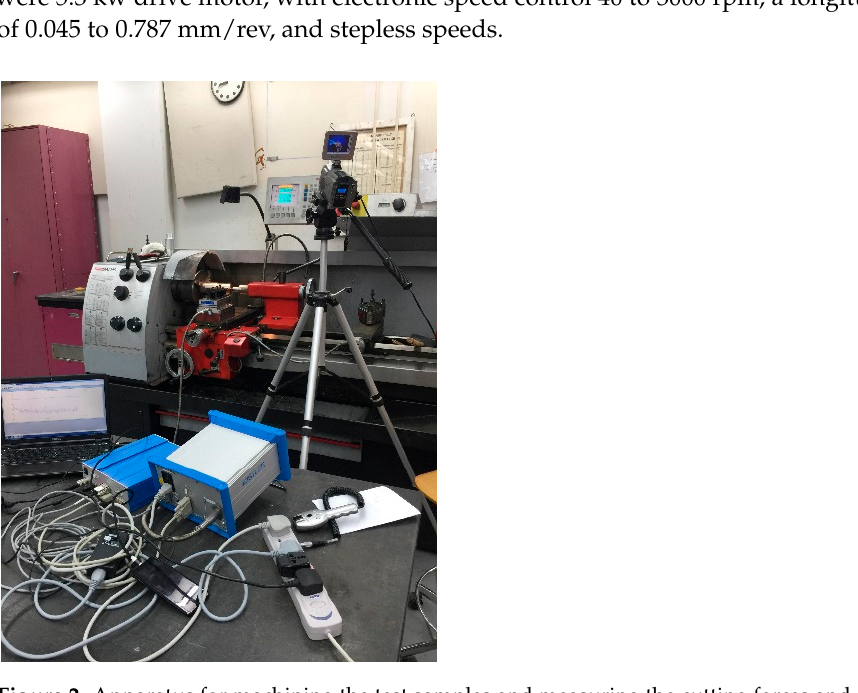
Figure 2. Apparatus for machining the test samples and measuring the cutting forces and tempera- ture.